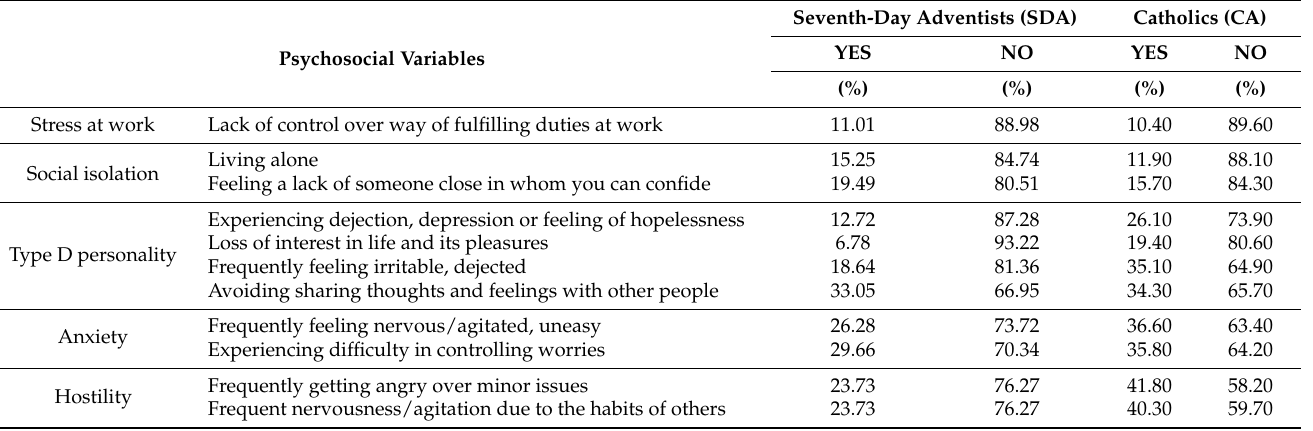
Table 9. Psychosocial risk factors for CVD among studied SDA and CA.